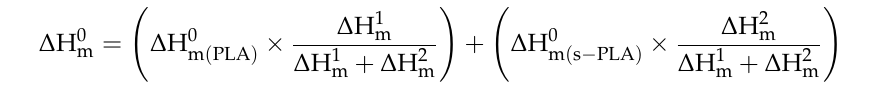
Table 2. Thermal evaluation of s-PLA formation through solution casting with various s-PLA crystallites content by DSC instrument.